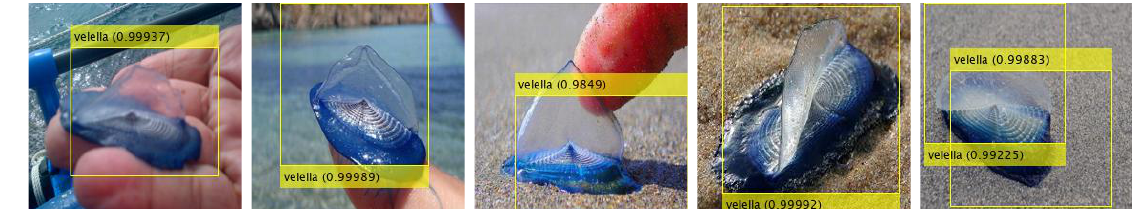
Figure 7. Output by classification model 5 for salps.